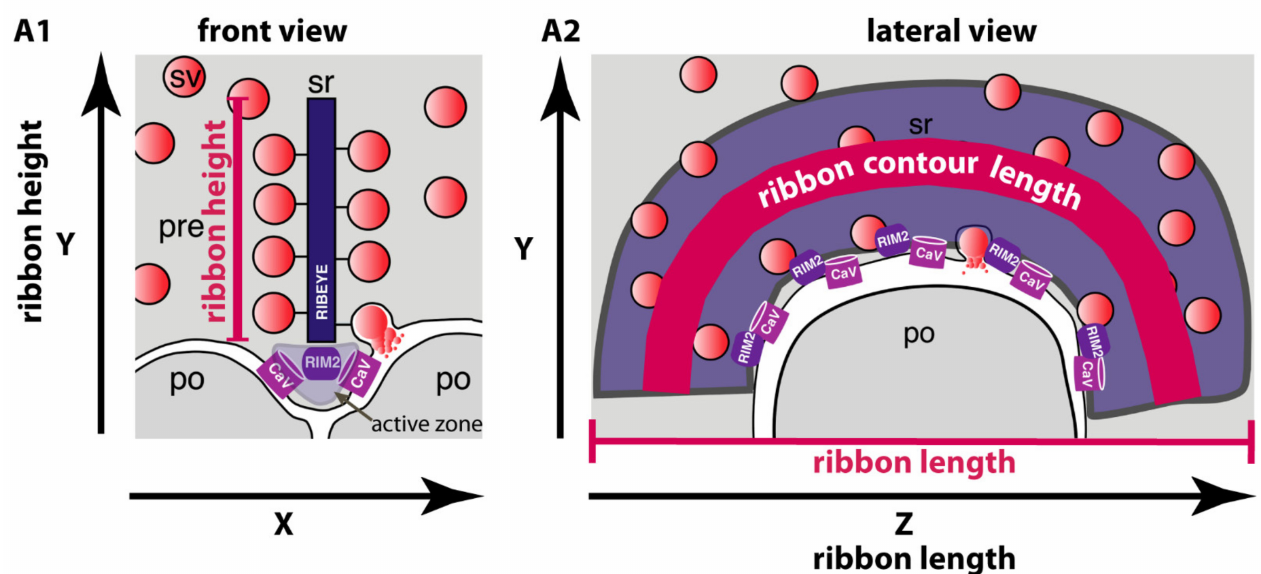
Figure 1. Schematic drawing of a rod photoreceptor synapse in two different views. ( A1 ) Cross section of a rod photoreceptor synapse showing a bar-shaped synaptic ribbon that is anchored perpendicularly to the active zone. Rod photoreceptor ribbon synapse sectioned in this way were considered for the measurement of the height of synaptic ribbon. ( A2 ) Lateral view of horseshoe-shaped synaptic ribbon that runs in parallel to the active zone. For the measurement of the synaptic ribbon length (in z-direction), serial ultrathin sections were analyzed by transmission electron microscopy. Abbreviations: po, post-synaptic; pre, pre-synaptic, sr, synaptic ribbon; sv, synaptic